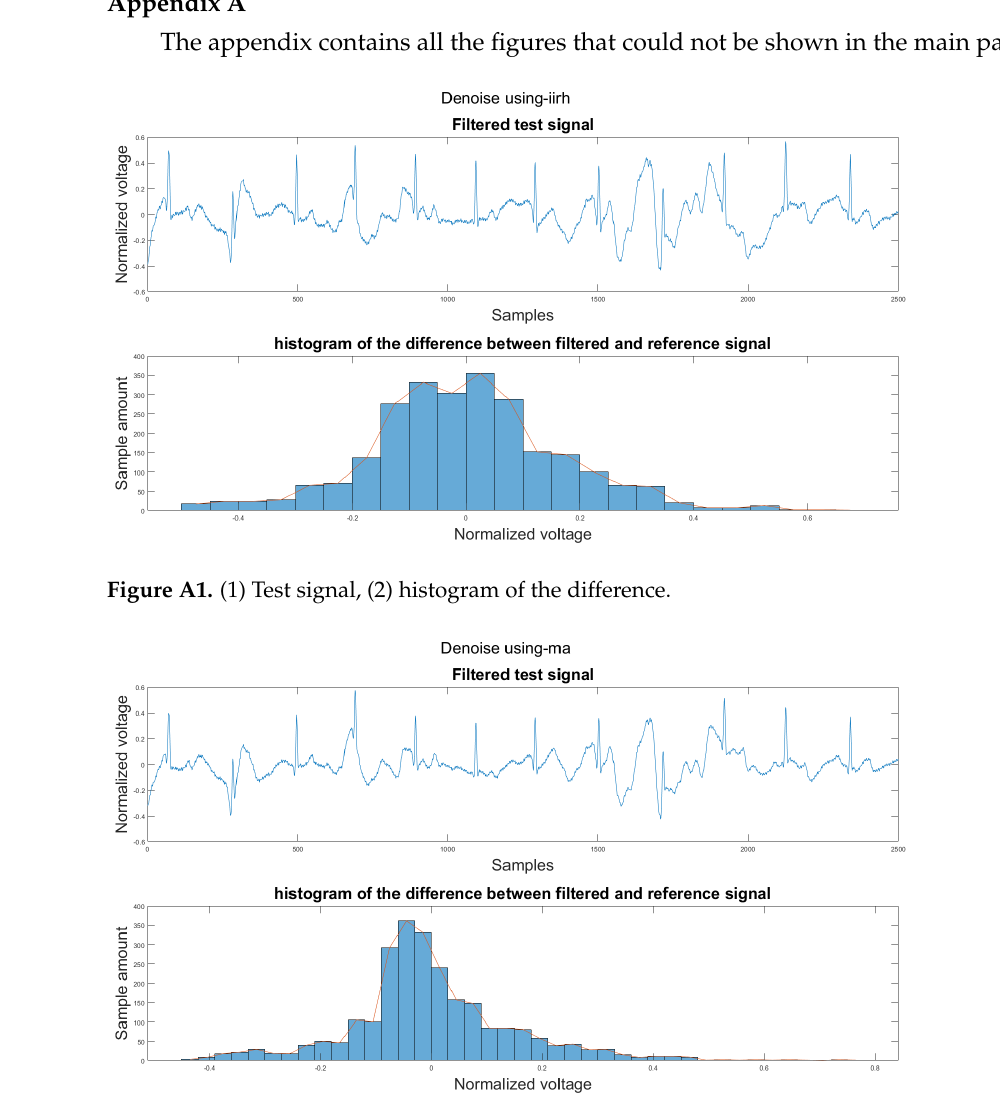
Figure A2. (1) Test signal, (2) histogram of the